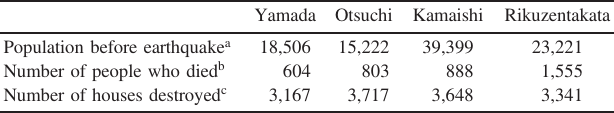
Table 1. Characteristics of study